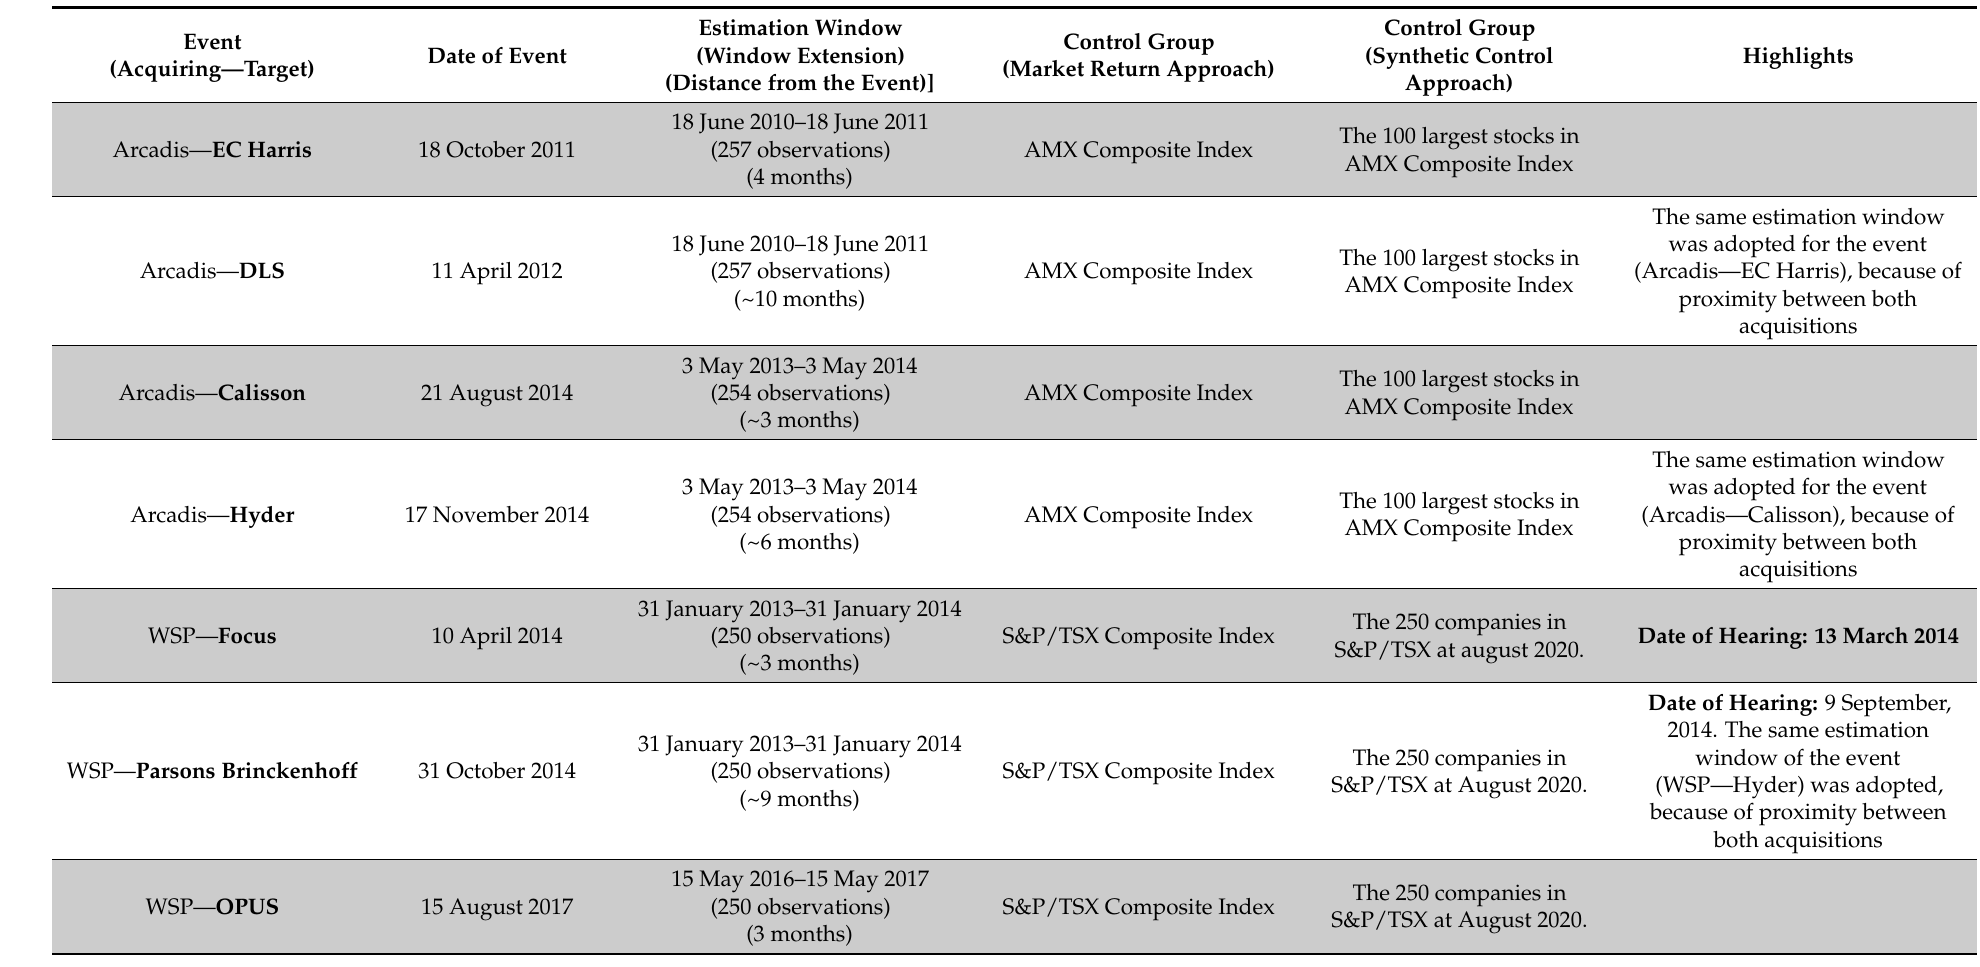
Table A1. Description of the main mergers and acquisitions (M&A) events of the five largest engineering companies between 2009 and